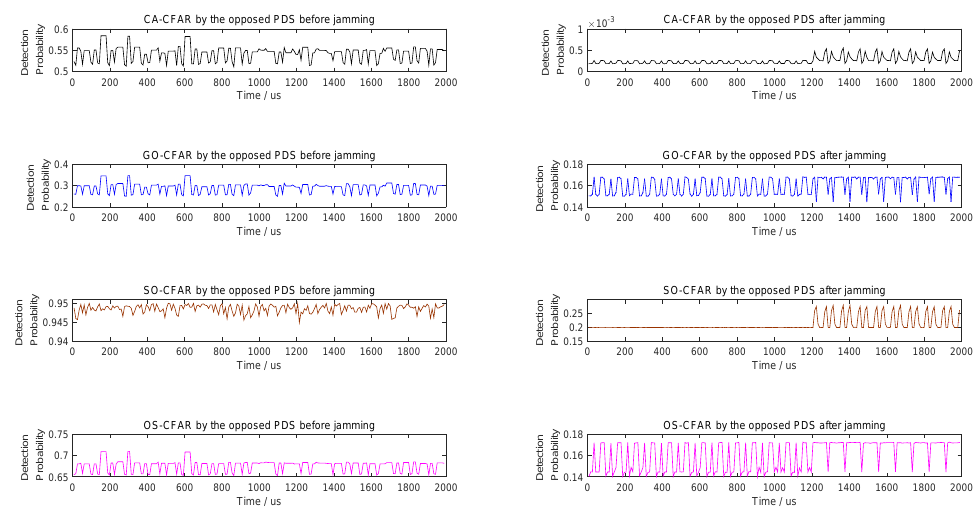
Figure 3. Detection probability of CA, GO, SO, and OS-CFAR before and after jamming when the number of reference units is 6.